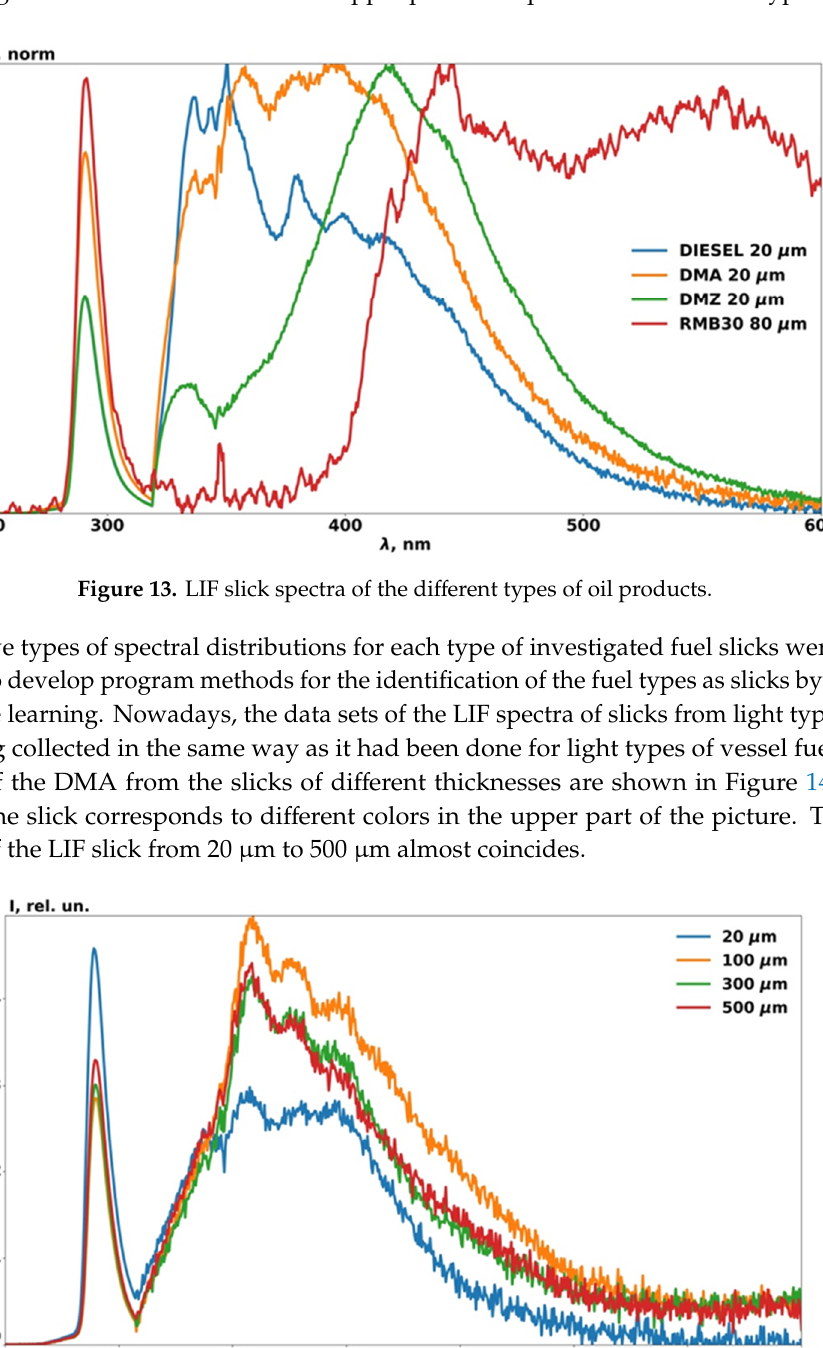
Figure 14. The form of the LIF spectra from the DMA slicks of different thicknesses.